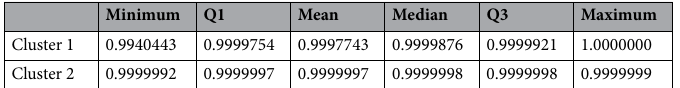
Table 5. Descriptive statistics for the membership degrees by